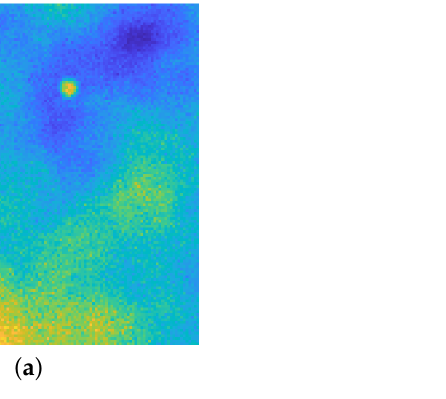
Figure 3. ( a ): the acquired image, affected by several artifact due to the blurring operator, Gaussian and Poisson noise and background emission, modeled by Perlin noise. ( b ): the desired output. Both images are displayed with values in [ 0,255 ] . The aim of the proposed upU-net is to remove only the Perlin noise: the experimental results will show that the typical behavior of such AE–like architecture will remove also the statistical noise. See Section 3 for the details about the generation of such